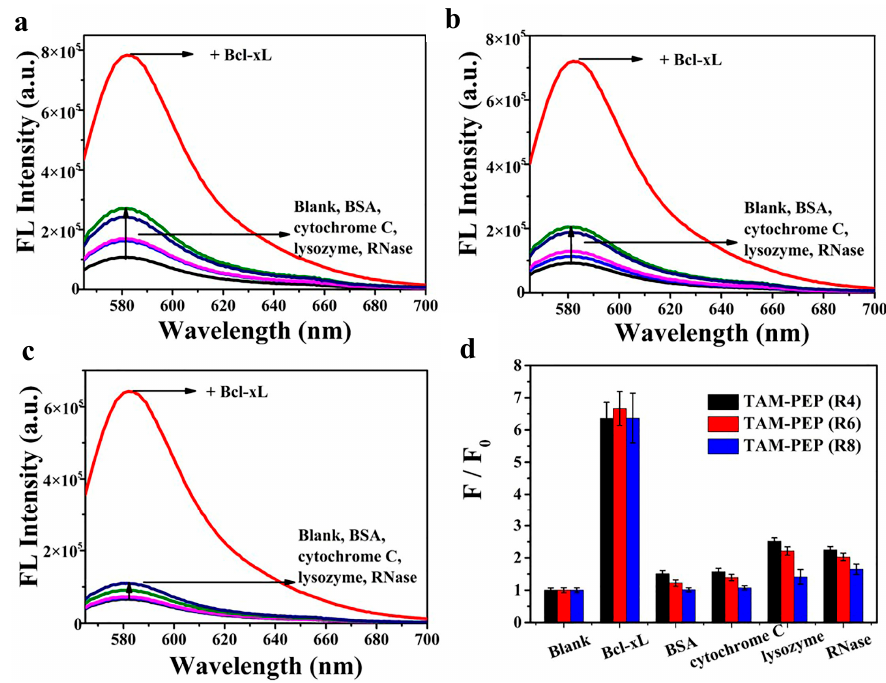
Figure 5. ( a – c ) Fluorescence intensity of TAM-PEP (R4), TAM-PEP (R6), TAM-PEP (R8) sensor in the presence of Bcl-xL (5 µ M), BSA (10 µ M), cytochrome C (10 µ M), lysozyme (10 µ M), and RNase (10 µ M) respectively; ( d ) Fluorescence recovery ratio (F/F 0 ) of TAM-PEP (R4), TAM-PEP (R6), TAM-PEP (R8) sensor in the presence of Bcl-xL (5 µ M), BSA (10 µ M), cytochrome C (10 µ M), lysozyme (10 µ M), and RNase (10 µ M) respectively, where F and F 0 were the fluorescence intensity with and without proteins.